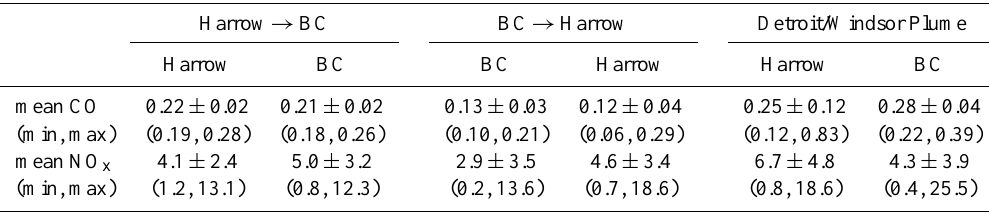
Table 2. Concentrations of CO (ppmv) and NO x (ppbv) at Harrow and Bear Creek during the Harrow-to-Bear Creek, Bear Creek-to- Harrow, and Detroit/Windsor plume case study periods. Mean, standard deviation, minimum, and maximum values are reported for each period. Data during the Harrow-to-Bear Creek period at the Harrow site exclude an event on 4 July (12:25 to 13:40) where NO x is elevated without perturbing either the particle composition or CO concentration. If this event is included, the table entry reads as follows: mean NO x =8.8 ± 17.9ppbv, minimum NO x =1.2ppbv, and maximum NO x